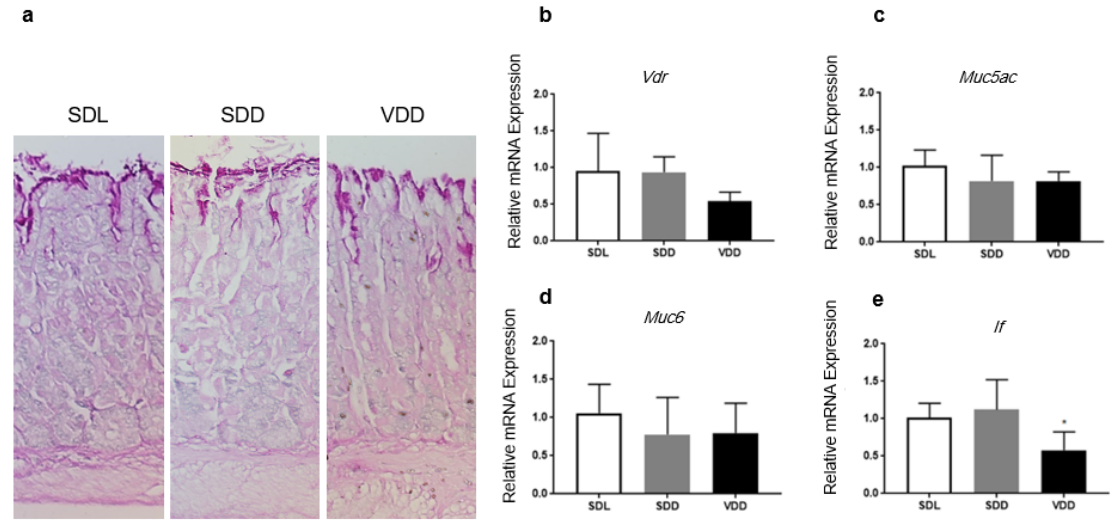
Figure 7. PAS staining and expression of cellular differentiation markers in VD-deficient mice. ( a ) No apparent difference in the PAS staining of gastric mucosa. RNA was obtained from the corpus regions of SDD, SDL and VDD mice ( n = 7/group) to evaluate the expression of representative genes by qPCR. Relative mRNA expression of ( b ) Vdr , ( c ) Muc5ac , ( d ) Muc6 and ( e ) If . If only showed a significant decrease in VD-deficient mice when compared with the controls. The data analysis was performed using a one-way ANOVA, * p < 0.05.